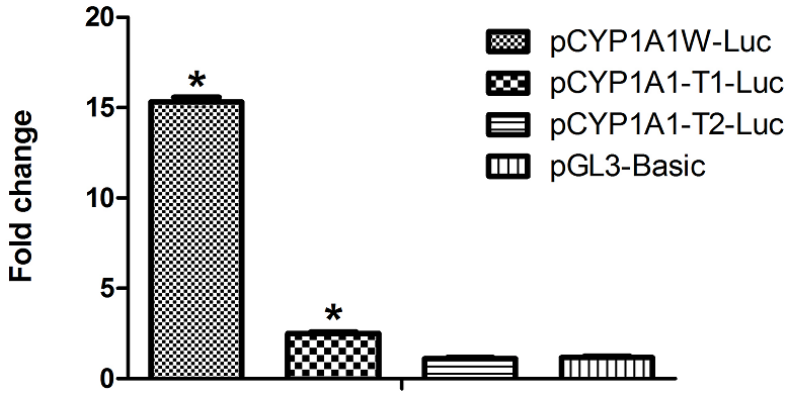
Figure 2. The putative DRE at position -488 is enough to activate AhR-dependent transcription. The mouse CYP1A1 promoter-reporter constructs, pCYP1A1W-Luc, which contains 1.4 kb of the promoter sequence, pCYP1A1-T1-Luc, which contains only one DRE at position -488, and pCYP1A1-T2-Luc, which contains no DREs, were transiently transfected into cultured Hepa wide-type (WT) cells one day before treatment. The transfected cells were incubated with 2,3,7,8-tetrachlorodibenzo- p -dioxin (TCDD) (10 − 9 M) or with solvent alone at 0.1% (control). After 24 h, luciferase assays were performed to determine the promoter activity of mouse CYP1A1. * p < 0.05, the difference from solvent-treated cells (control) by one-way ANOVA with Tukey’s